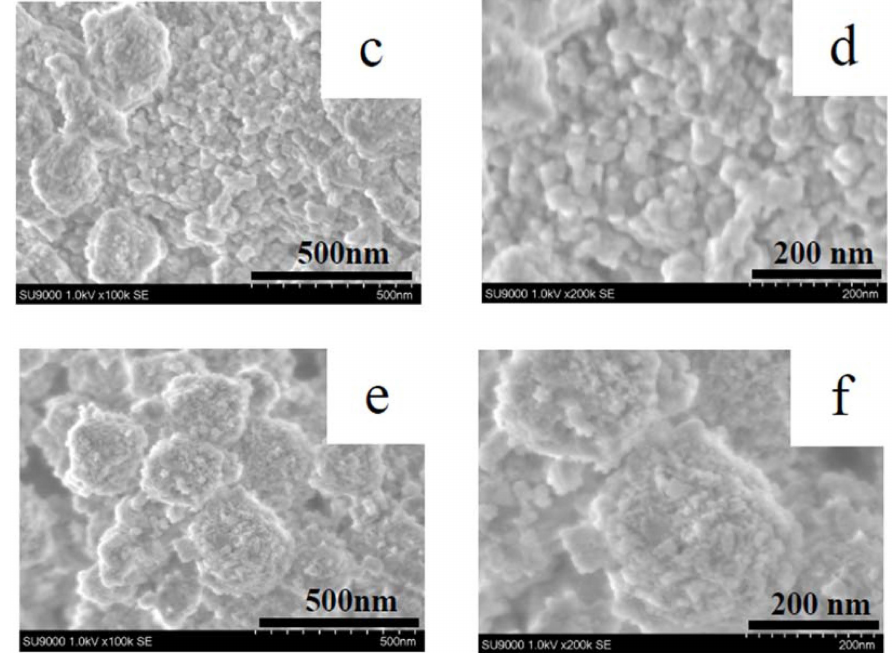
Figure 3. SEM images of HB(77)-AT(0.05 M) ( a , b ); HB(77)-AT(0.2 M) ( c , d ); and HB(77)-AT(0.05 M)-NT(1 M) ( e , f ) catalysts.